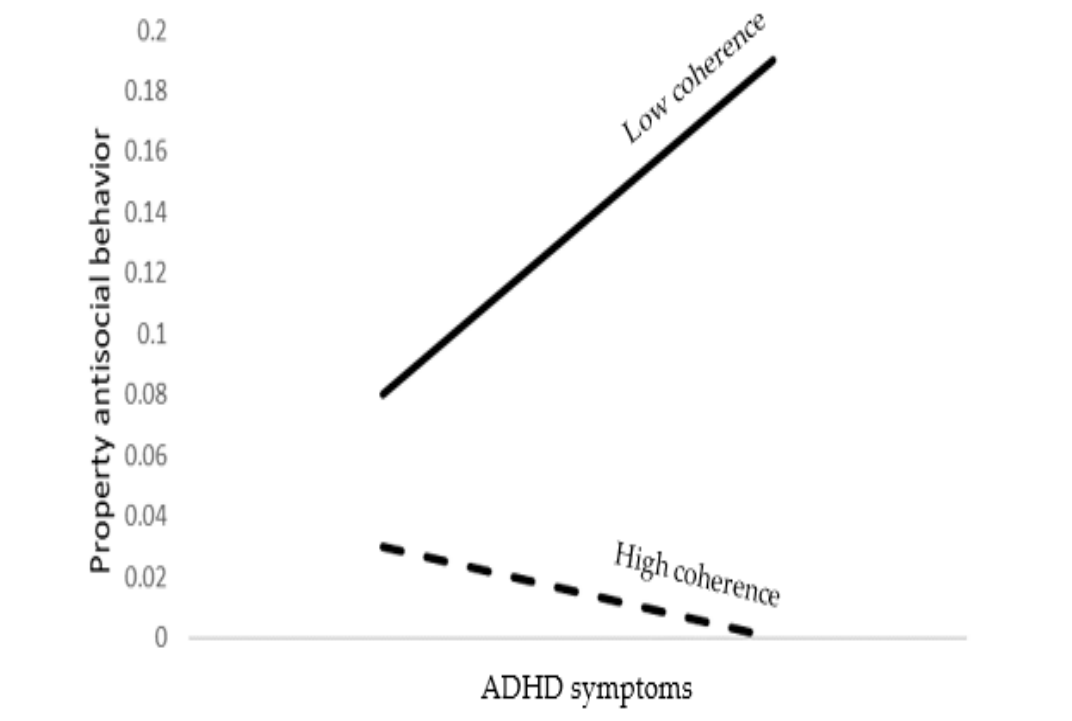
Figure 4. The association between ADHD symptoms and property crimes as moderated by coherence. Table 7. ADHD symptoms as a predictor of public order antisocial behavior moderated by coherence.